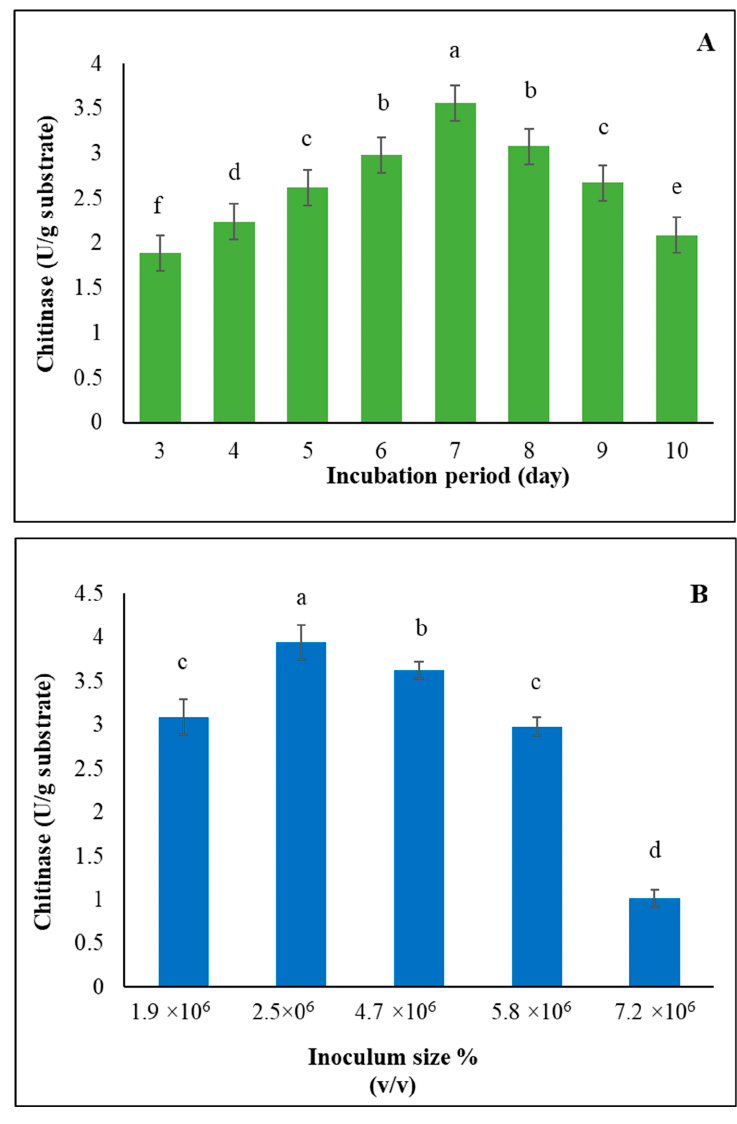
Figure 3. Effect of the incubation period ( A ) and inoculum size ( B ) on the production of chitinase on SSF by T. funiculosus strain CBS 129594. The values are the means of three replicates with standard deviation (±SD). Mean values in each bar followed by a different lower-case letter are significantly different according to Duncan’s multiple range tests at p ≤ 0.05.